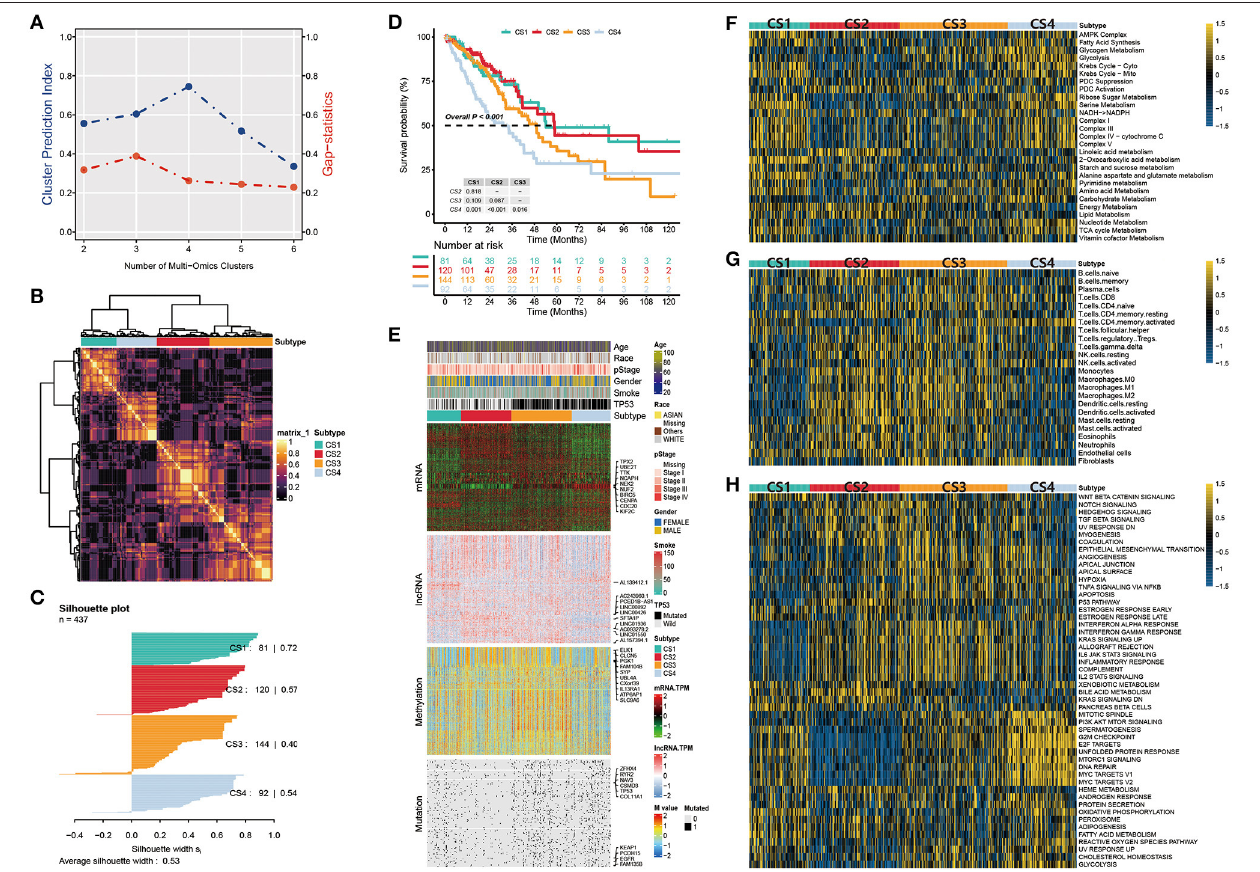
FIGURE 2 | (A) Identification of the optimal number of clusters by calculating CPI (blue line) and the gap statistic (red line) in the LUAD cohort. (B) Consensus heatmap based on the results of five multi-omics comprehensive clustering algorithms with a cluster number of 4. (C) Silhouette scores were used to quantify sample similarity based on the consensus clustering results. (D) Kaplan-Meier survival analysis of overall survival in the four subtypes. (E) Comprehensive heatmap of multi-omics integrative clustering by five clustering algorithms with annotation of the top features. (F) Heatmap of specific metabolism-related pathways in the four subtypes. (G) Heatmap of specific immune-related pathways in the four subtypes. (H) Heatmap of specific tumor-associated pathways in the four